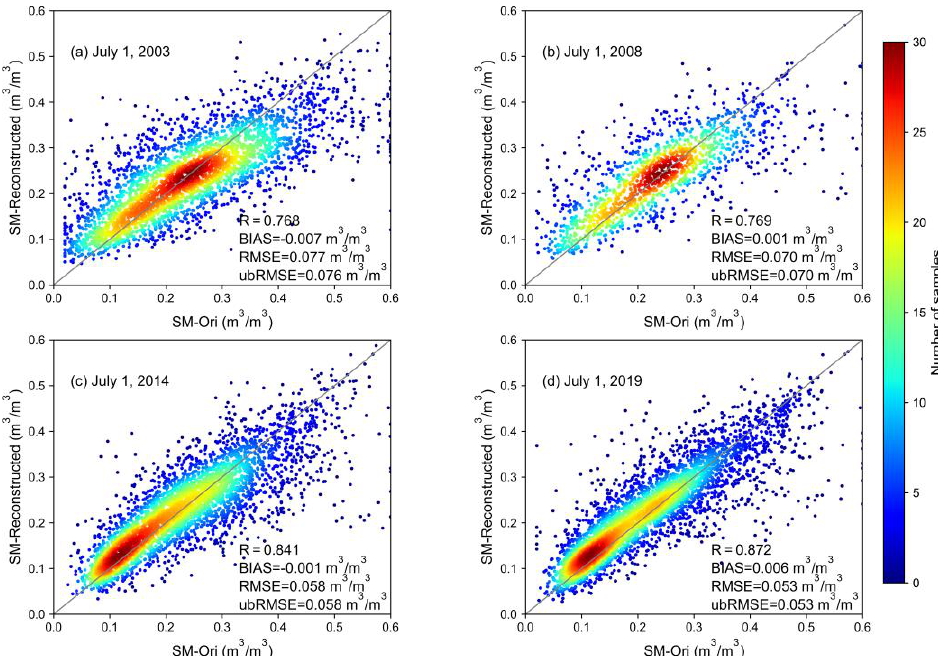
Figure 10. Scatterplots of the reconstructed surface soil moisture against and original values over the sub-regions on 1 January of 2003, 2008, 2014 and 2019. Note: the color density indicates the num- ber of samples .